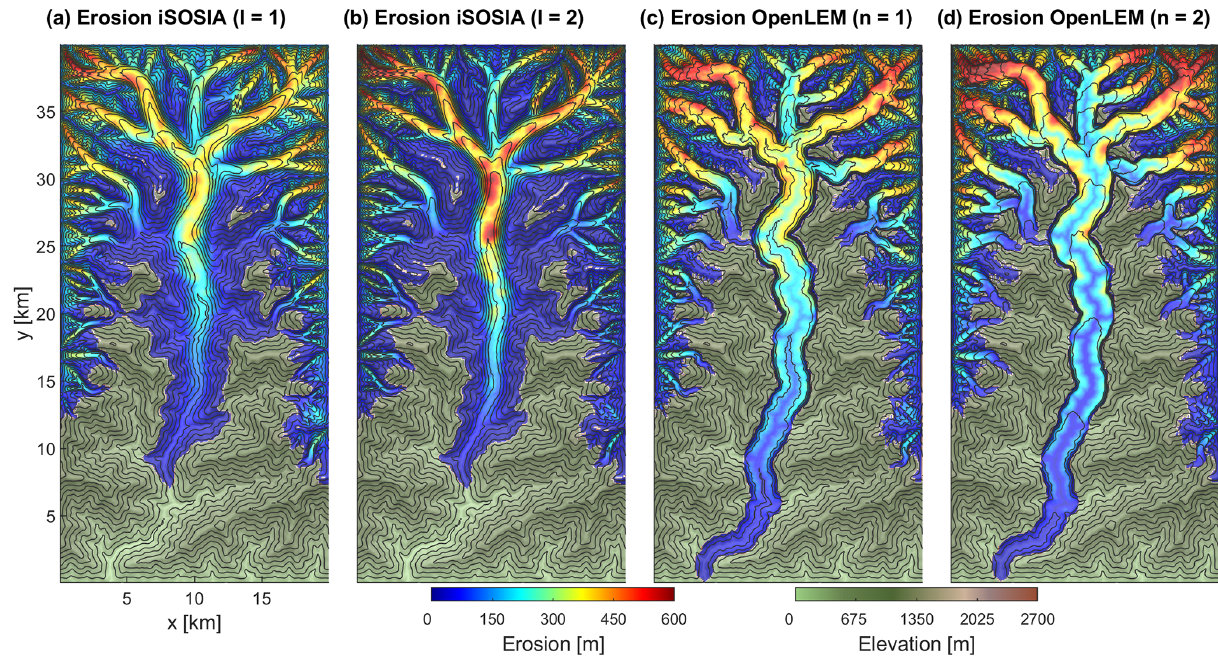
Figure 12. Differences in the evolving erosion pattern with n and l = 1 or 2 of OpenLEM and iSOSIA. Erosion is measured over a time span of 100kyr. Contour spacing is